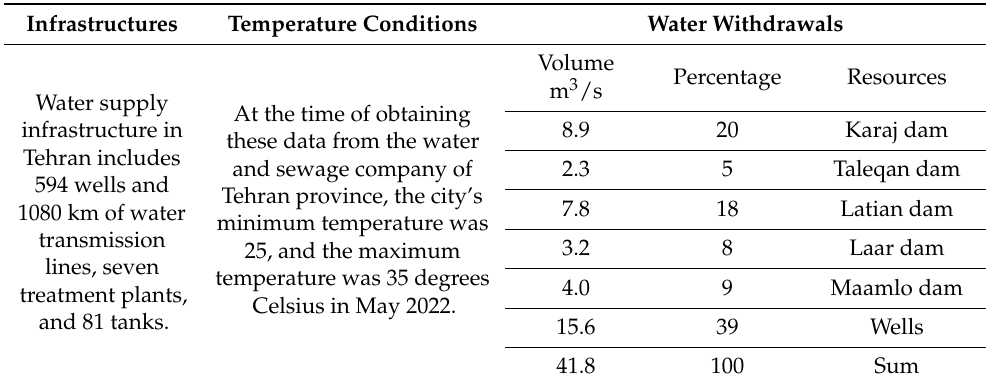
Table 2. Water resources of Tehran city and the percentage of participation in Tehran’s water supply